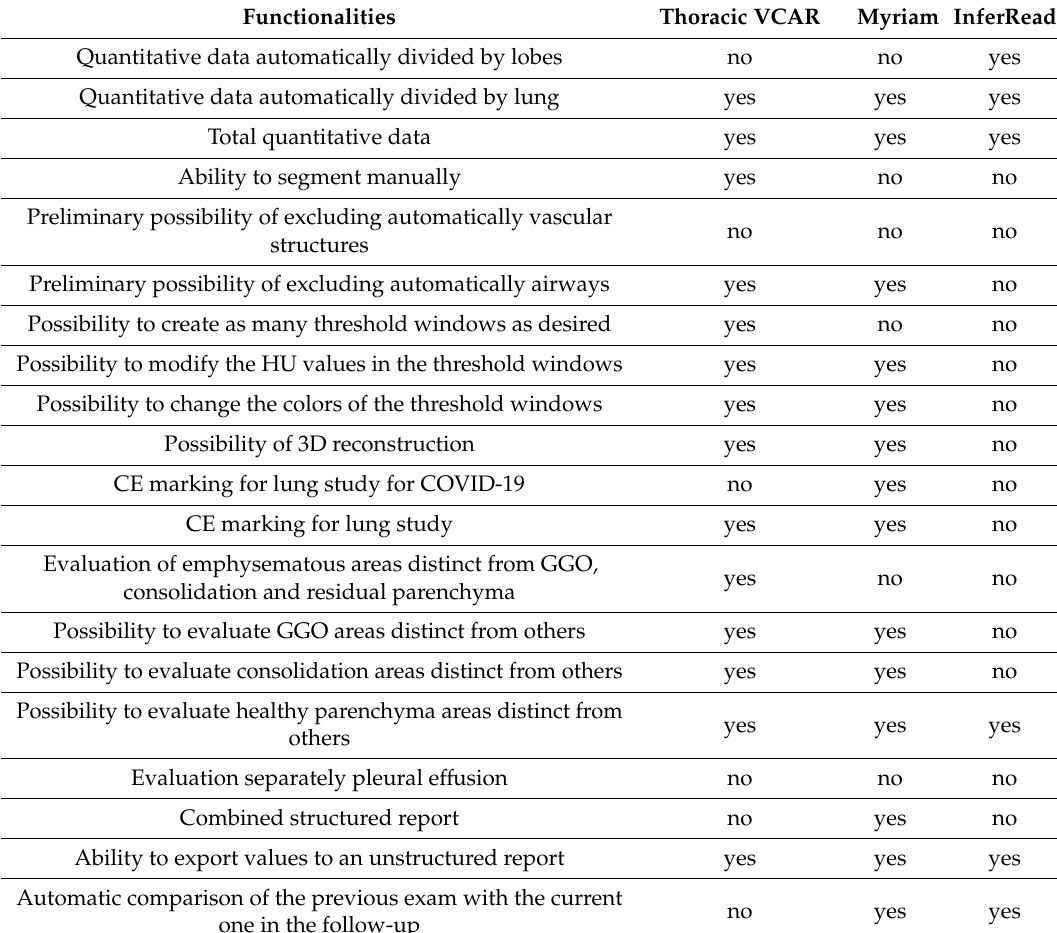
Table 1. Description of computed based tool functionalities. Functionalities Thoracic